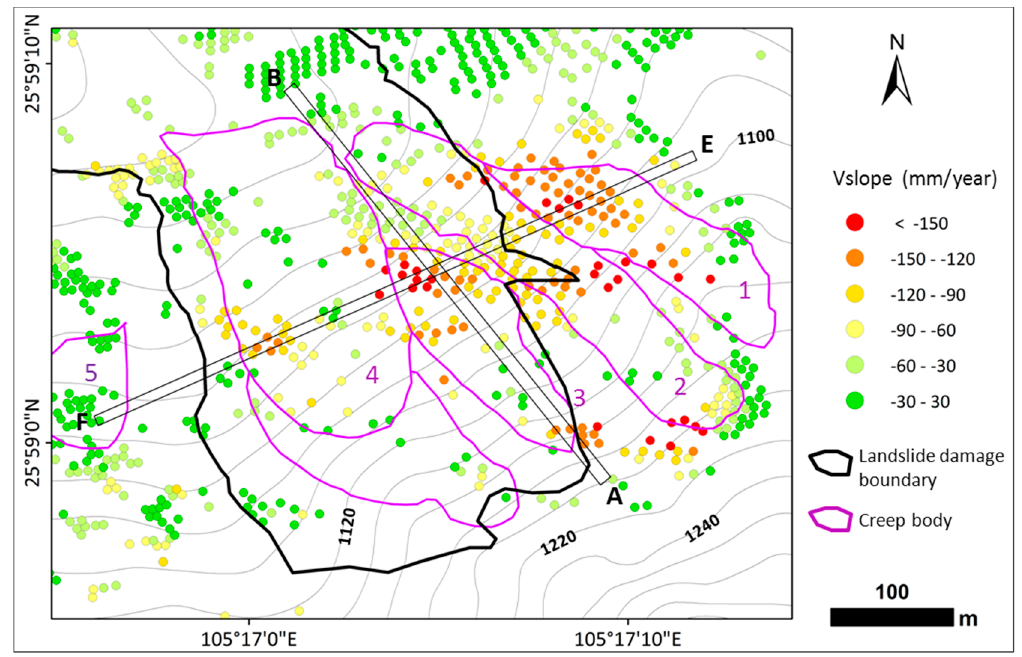
Figure 6. Average pre-slide deformation rate map along the slope direction for the source area of the Guanling landslide. The solid lines AB and EF denote profiles across the source area.